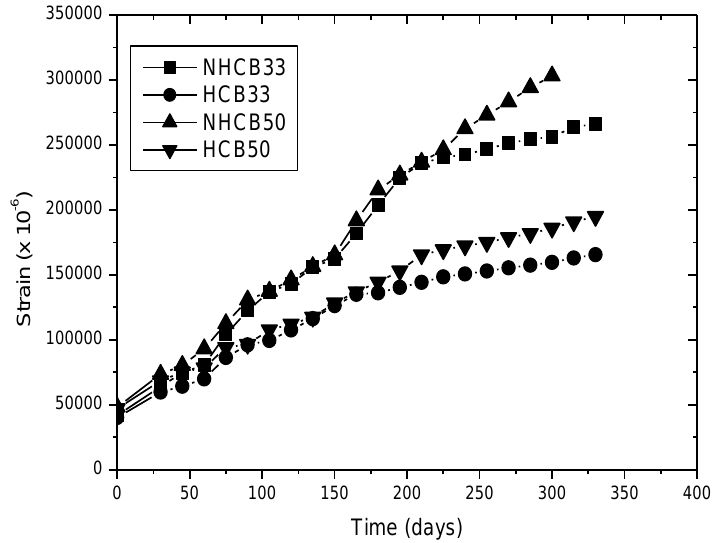
Figure 8. Longitudinal concrete tensional strains under sustained loading.